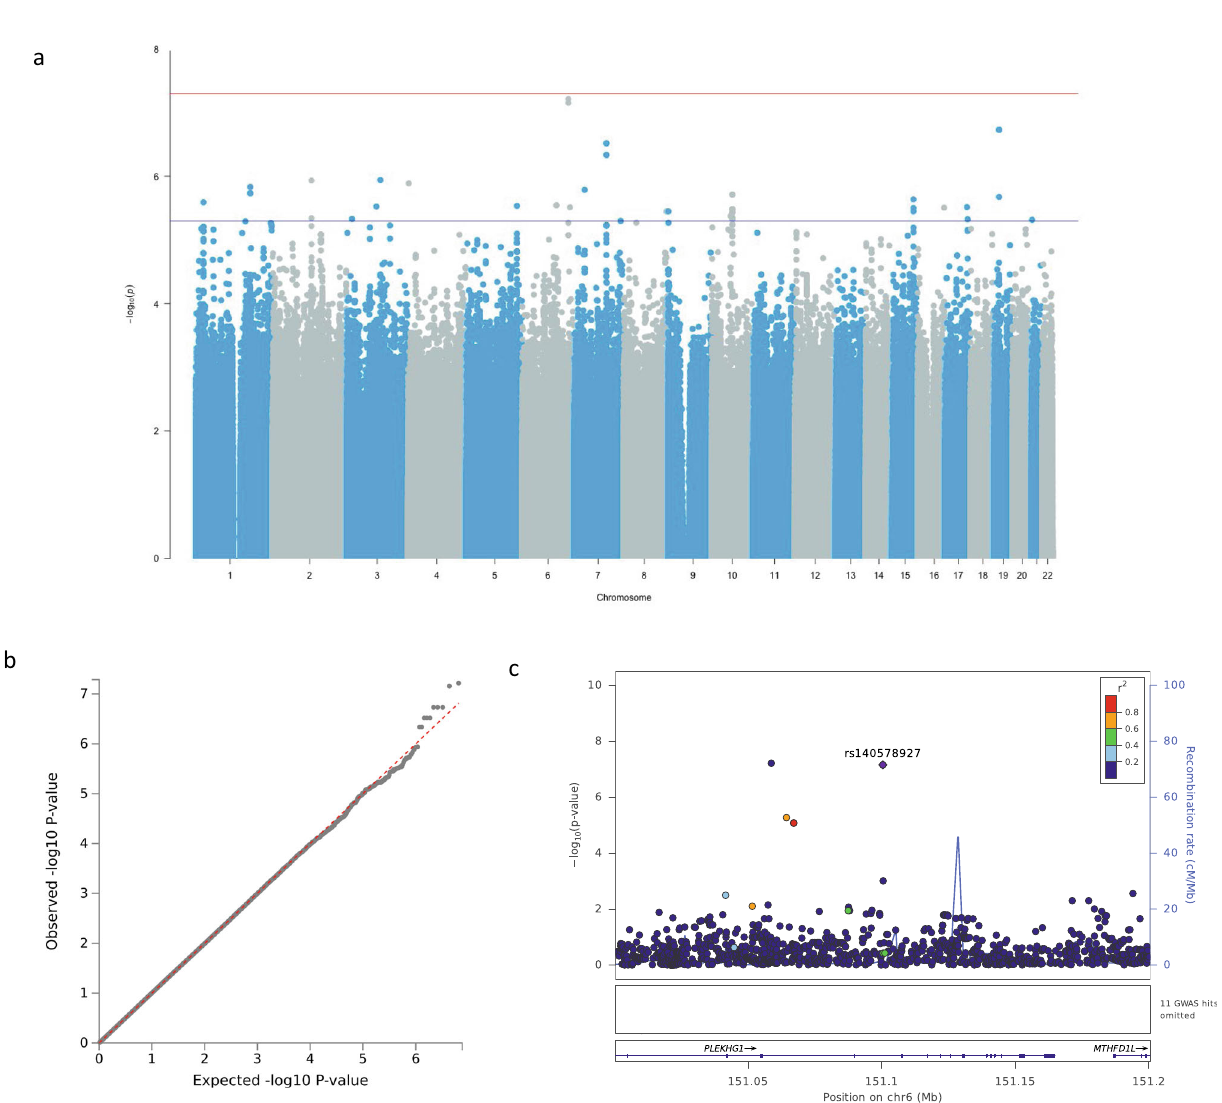
Fig. 2 Genome-wide and suggestive associations with language. a Manhattan plot. Genome-wide signi fi cance cut-off 5 × 10 − 8 is shown by a red line, and suggestive cut-off 5 × 10 − 6 is shown by a blue line. b QQ-plot ( λ = 1.00) for association summary statistics. c Locus zoom plot for rs140578927. LD values are based on a South African LD panel. (Supplementary Table 1) suggested two genes encoding mito- Genome-wide analysis results for executive function yielded chondrial proteins on chromosome 15; MRPL46 associated with depressive